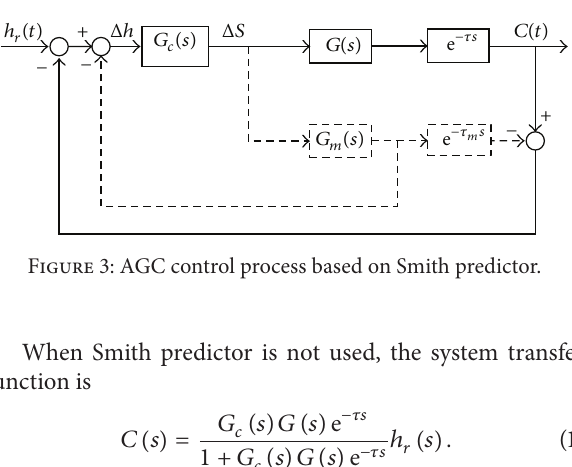
Figure 2: RM fiber optic network in a tandem rolling line.